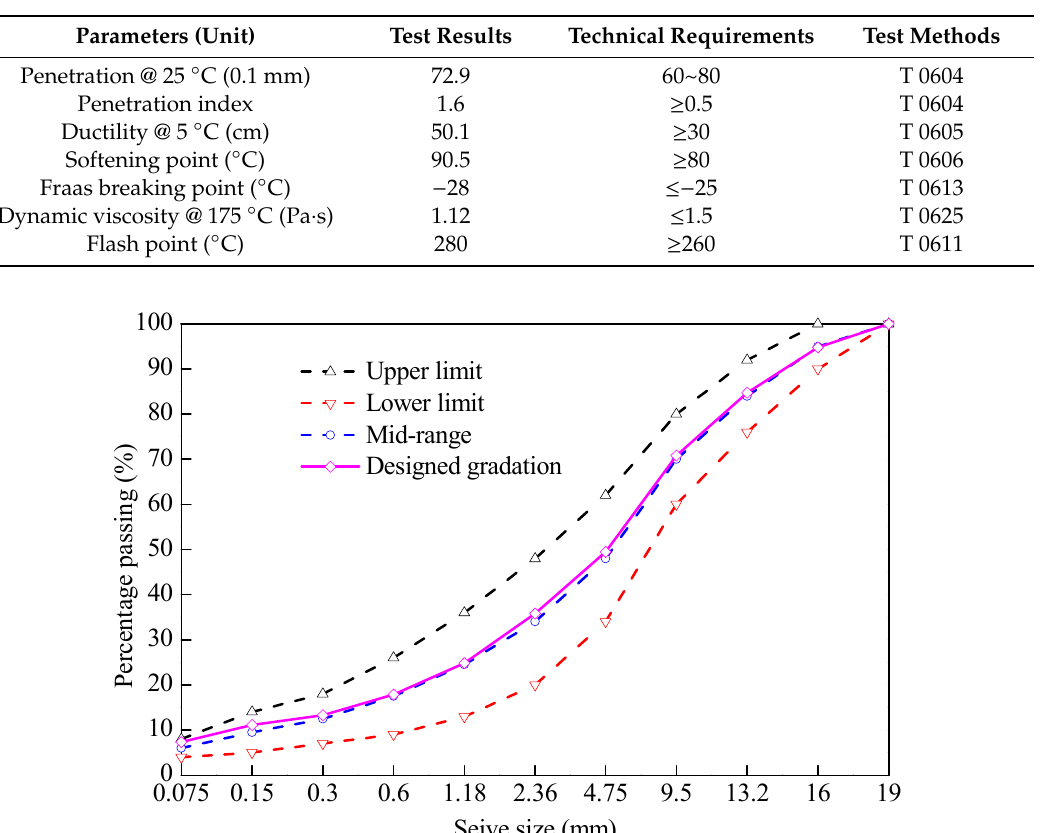
Table 1. Basic properties of the styrene-butadiene-styrene (SBS) + tough polystyrene (TPS)-modified asphalt binder.